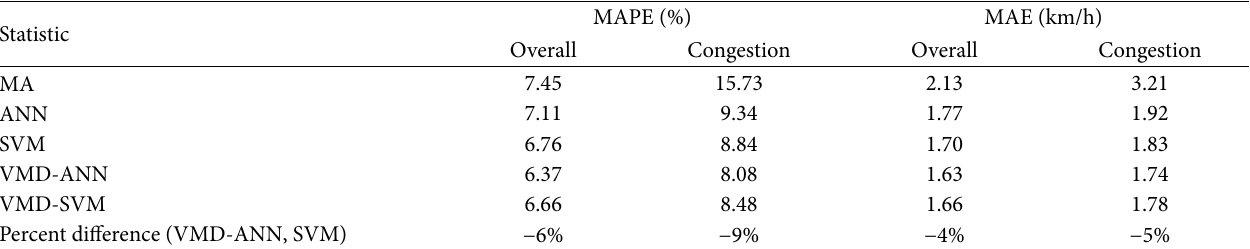
Table 1: Comparison of performances of benchmark models and proposed